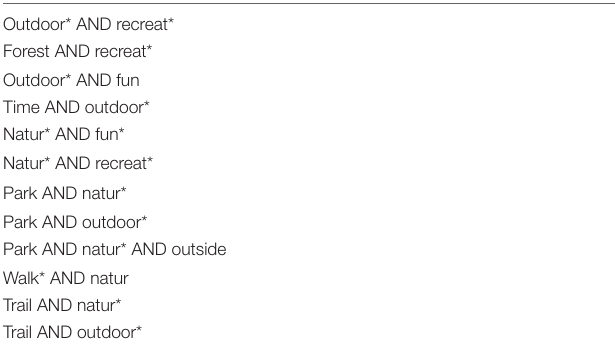
TABLE 1 | Nature and greenspace keywords and hashtags included in search parameters for collecting